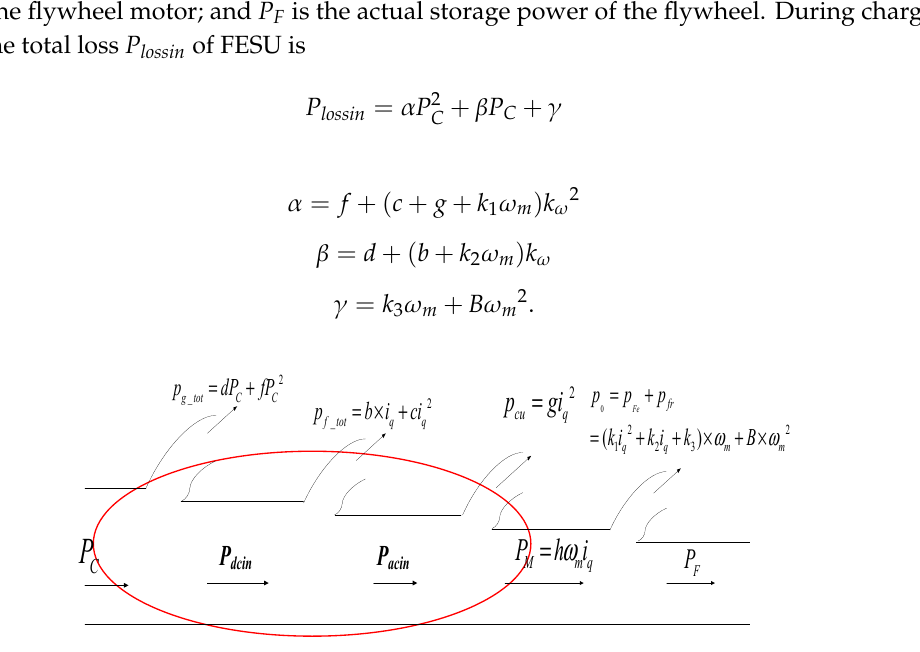
Figure 5. Energy flowing in the FESU during charging.